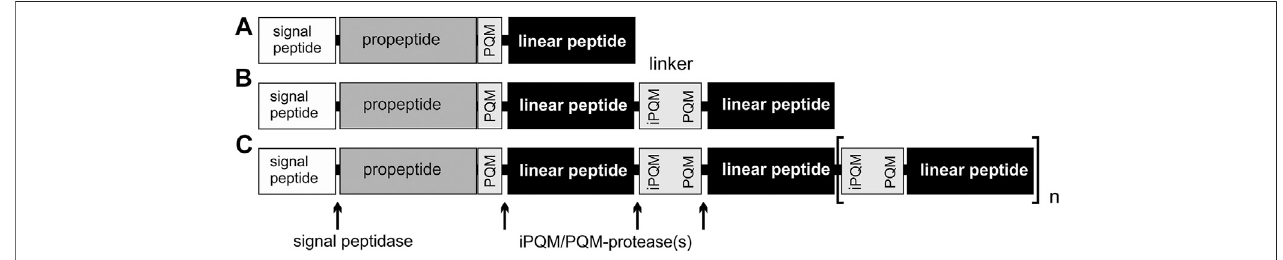
FIGURE 3 | Overview of different precursor structures. (A) Simple precursor structure. (B) Binary precursor structure. (C) Complex precursor structure, which allows at least 13 connected peptides. Linkers are peptides, with an N-terminal iPQM motif and a C-terminal PQM motif, which connect linear peptides.